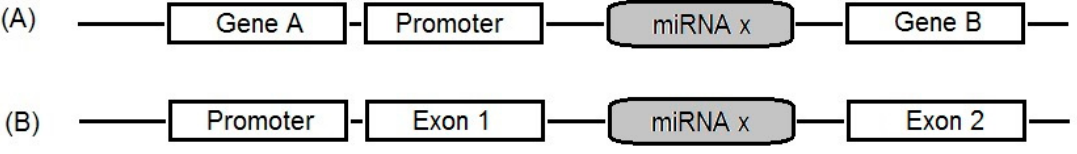
Figure 1. Location of the microRNA (miRNAs) gene in the genome: ( A ) intergenic miRNAs: miRNAs located between two genes; ( B ) intronic miRNA: miRNAs located in the region of intron in a gene.